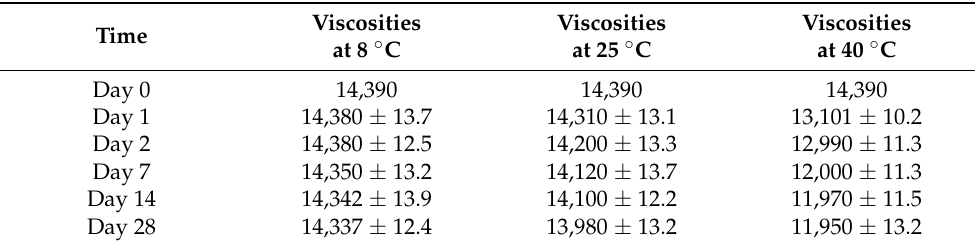
Table 2. Viscosities (Centipoise) of ELE2 at the indicated temperature and time. Time